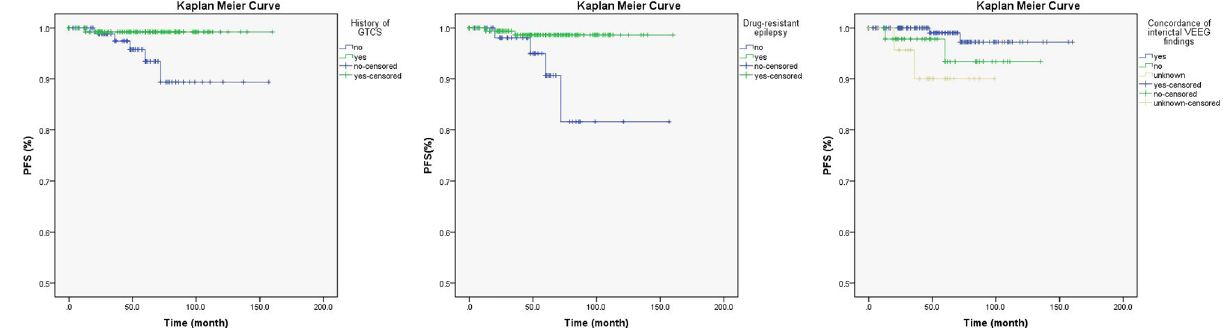
Figure 1. The comparison of Kaplan Meier curves of significant clinical factors in univariate Cox regression analysis, including drug-resistant epilepsy (left), history of generalized tonic–clonic seizure (GTCS; middle) and concordance of interictal video electroencephalogram (VEEG) findings (right).